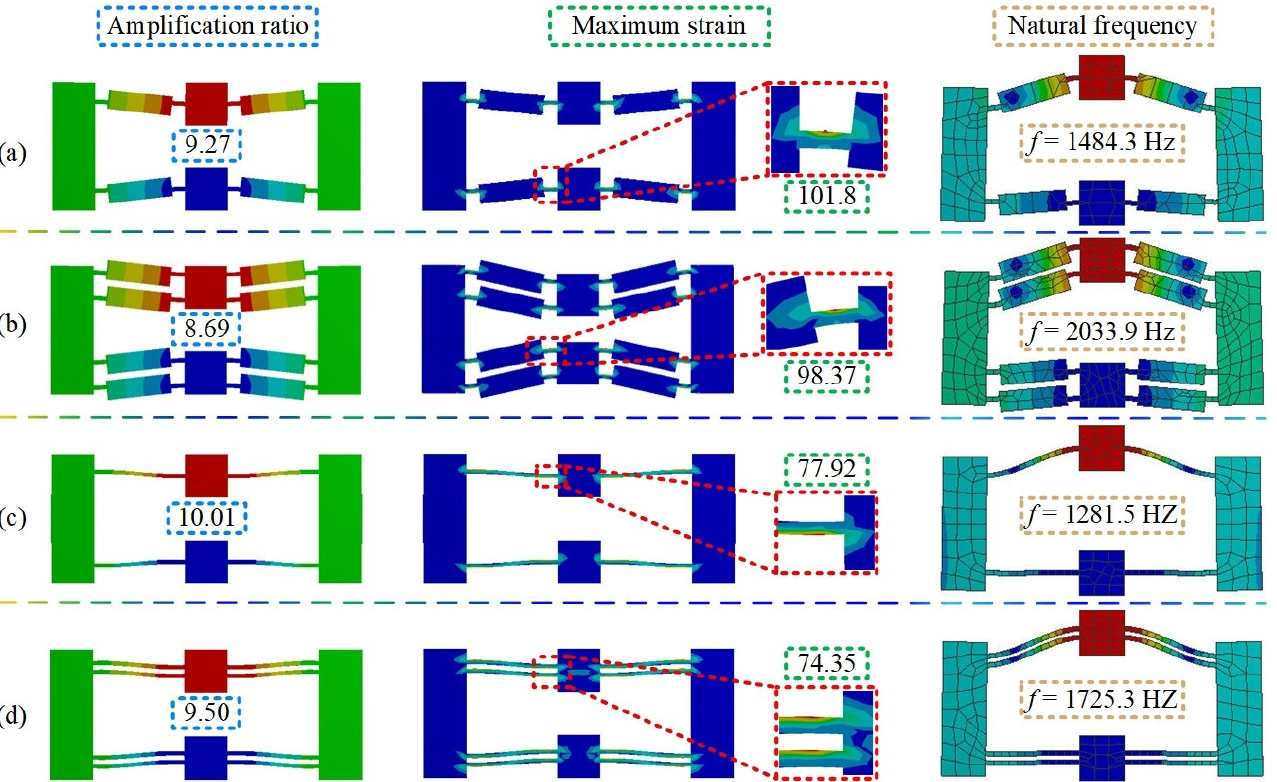
Figure 3. Simulation of bridge-type amplification mechanisms: ( a ) single-beam rectangular mecha- nism; ( b ) double-beam rectangular mechanism; ( c ) single-beam diamond mechanism; ( d ) double- beam diamond mechanism.